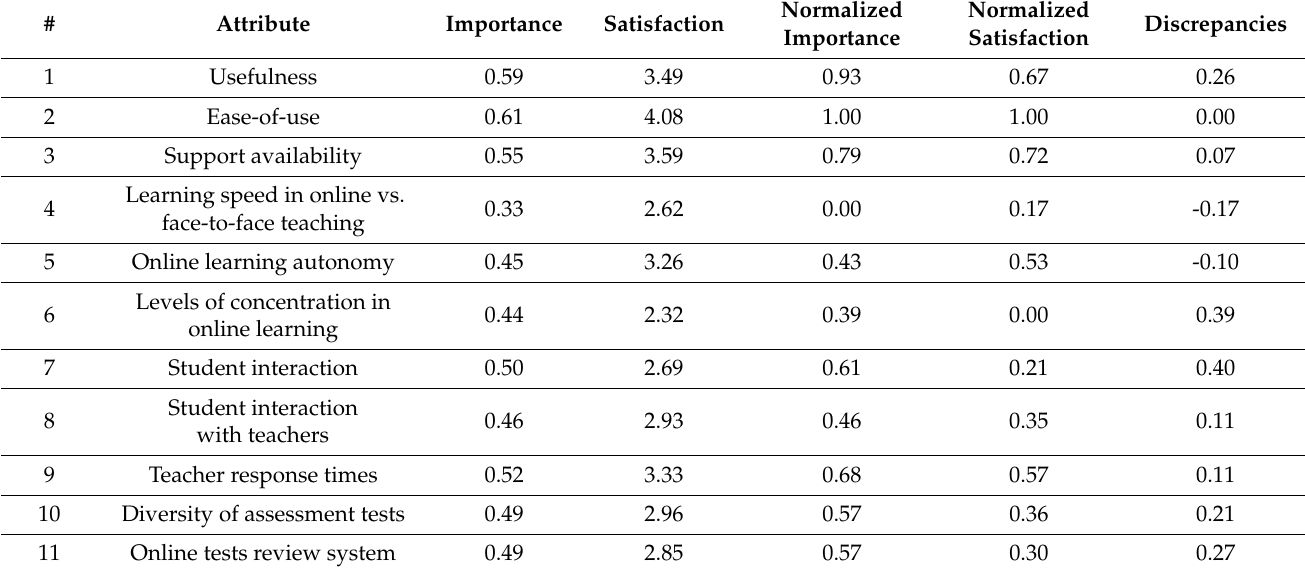
Table 9. Importance, satisfaction and